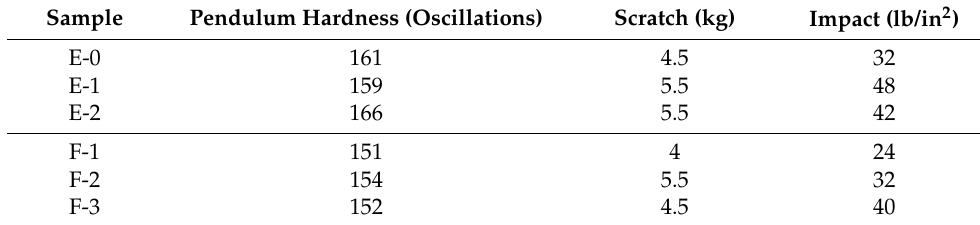
Table 3. Pendulum hardness, Scratch and Impact Resistance obtained for PA-450 and PA-3282.